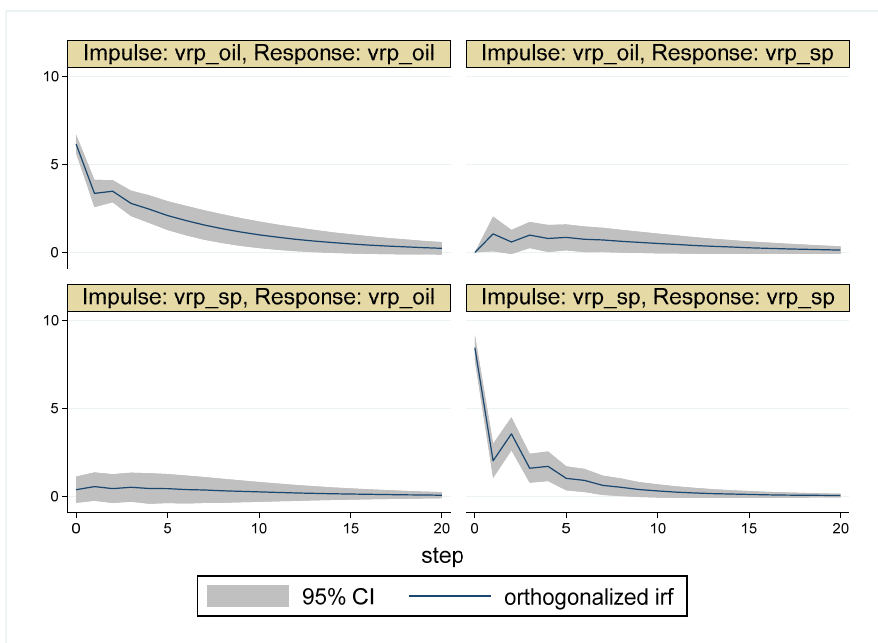
sp before VRP oil (Period